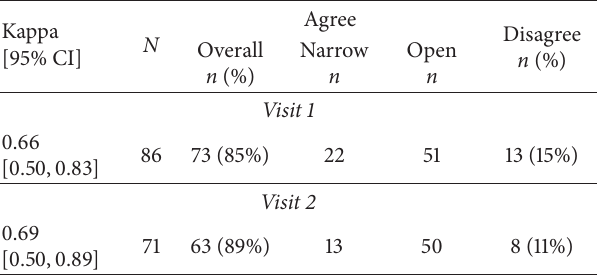
Table 2: Gonioscopy “pooled” interobserver agreement for angle classification (kappa [95% confidence